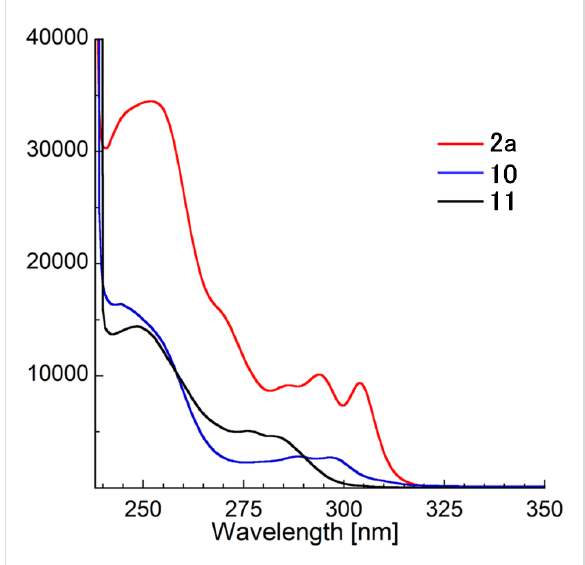
Figure 3: Absorption spectra of selected compounds ( 2a , 10 and 11 ) in CHCl 3 .